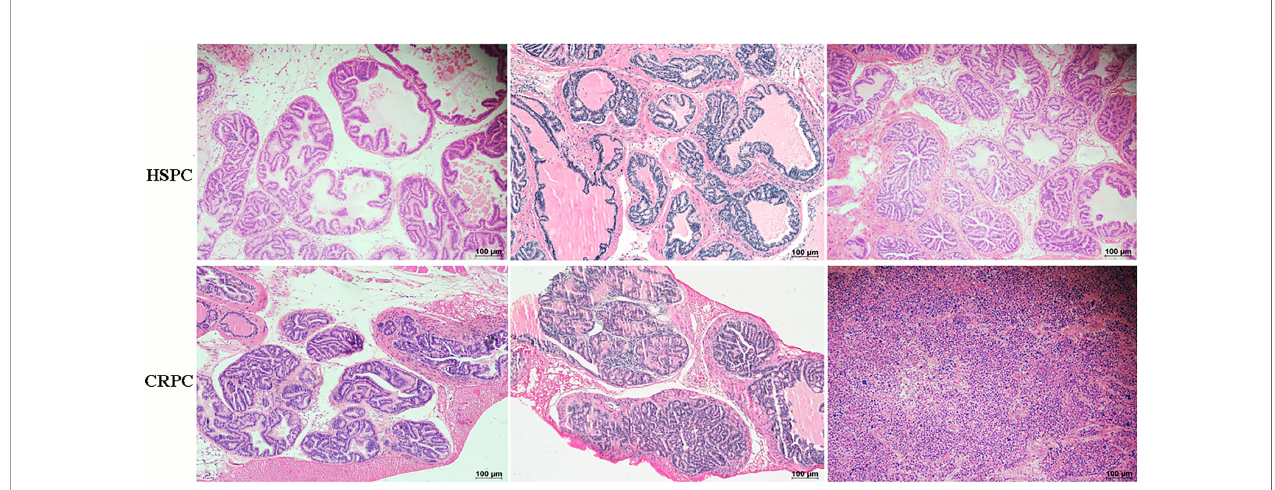
FIGURE 3 | Histopathological images of mice prostate after FMT. FMT with CRPC feces signi fi cantly accelerated mice ’ s PCa progression. The bar represents 100 µm.